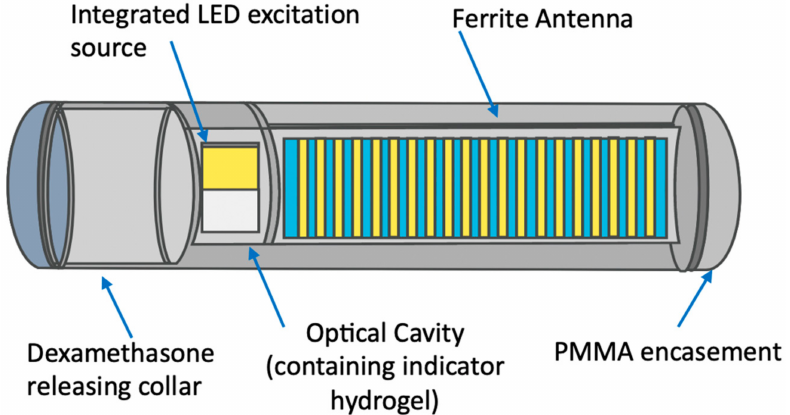
Figure 2. Scheme of the Senseonics Eversense implanted module probe containing one or two (depending on the model—for 90 or 180 days) silicon collars slowly releasing dexamethasone to diminish the inflammatory response in the implantation site. The indicator polymer is in proximity of the optical system that flashes the UV-LED to measure the fluorescence intensity of the indicator gel. The controller performs the measurements and connects to the externally worn transmitter wirelessly to collect and store data points. From [22] with permission from